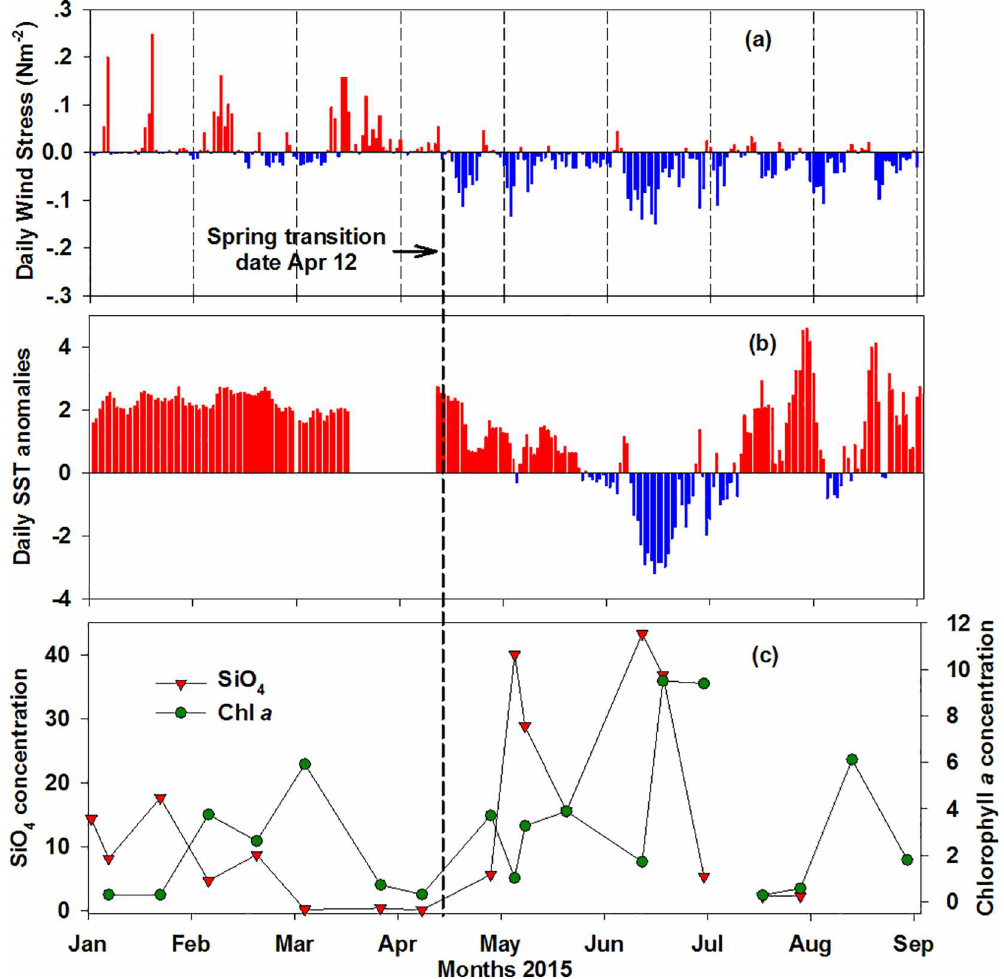
Daily alongshore wind stress (N m -2 ). Red bars indicate southerly winds (downwelling/relaxation of upwelling)and blue bars indicate northerly winds (upwelling).(b) Daily sea surface temperatureanomalies(coloredbars, SST